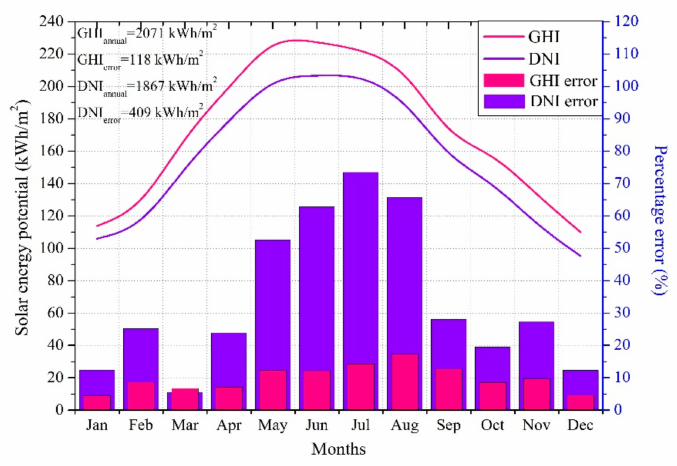
Figure 9. Solar energy potential in kWh / m 2 and percentage error (%) of GHI and DNI, as compared to the BSRN measurements in